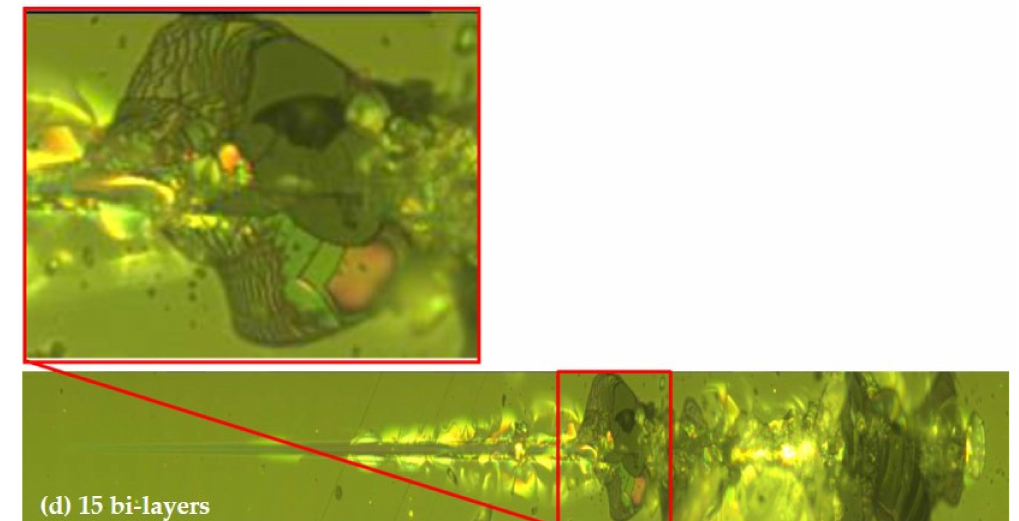
Figure 5. Scratch test track optical images. ( a ) 5 bi-layer scratch track. ( b ) 10 bi-layer scratch track. ( c ) 15 bi-layer scratch track. ( d ) 15-layer test track and zoomed-in region illustrating the clear 15 layers that appear to have peeled away from the